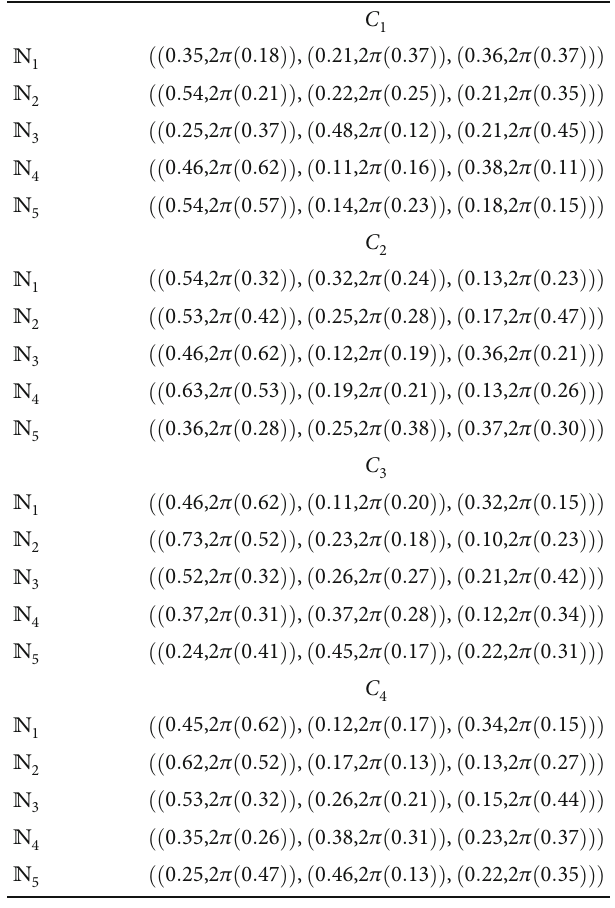
Table 3: Preferences for alternatives provided by expert E ð 3 Þ .